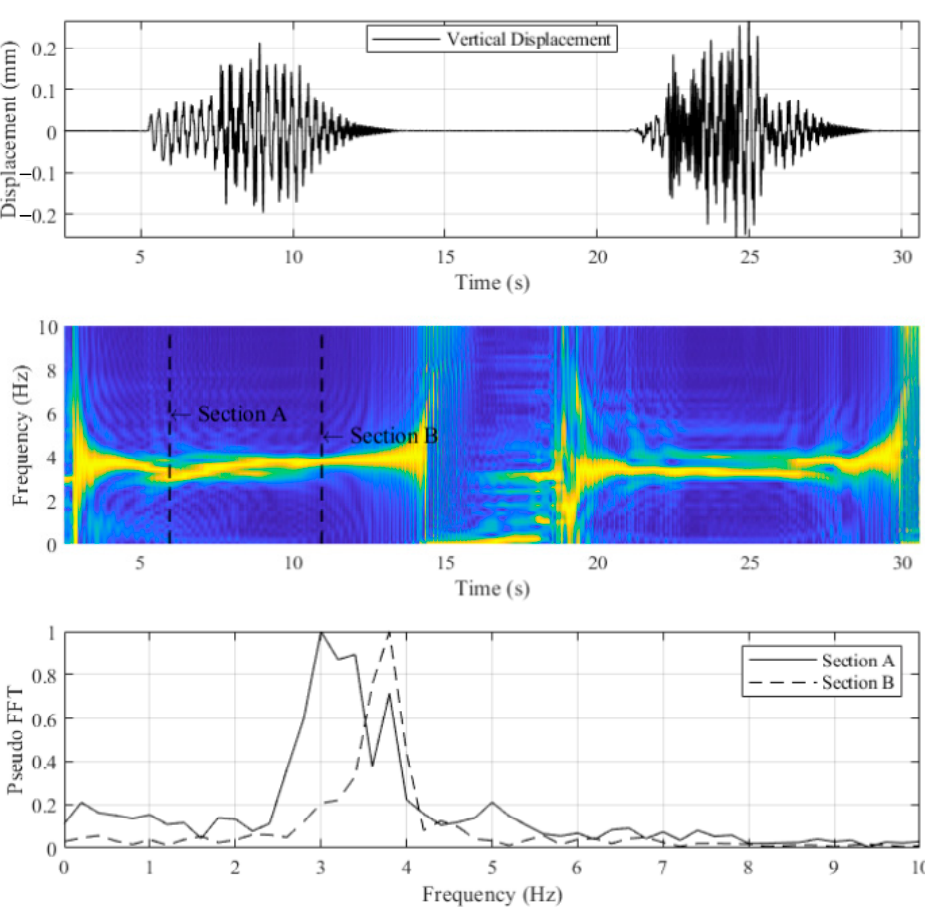
Figure 13. Windowed FFT of LVB0S3.